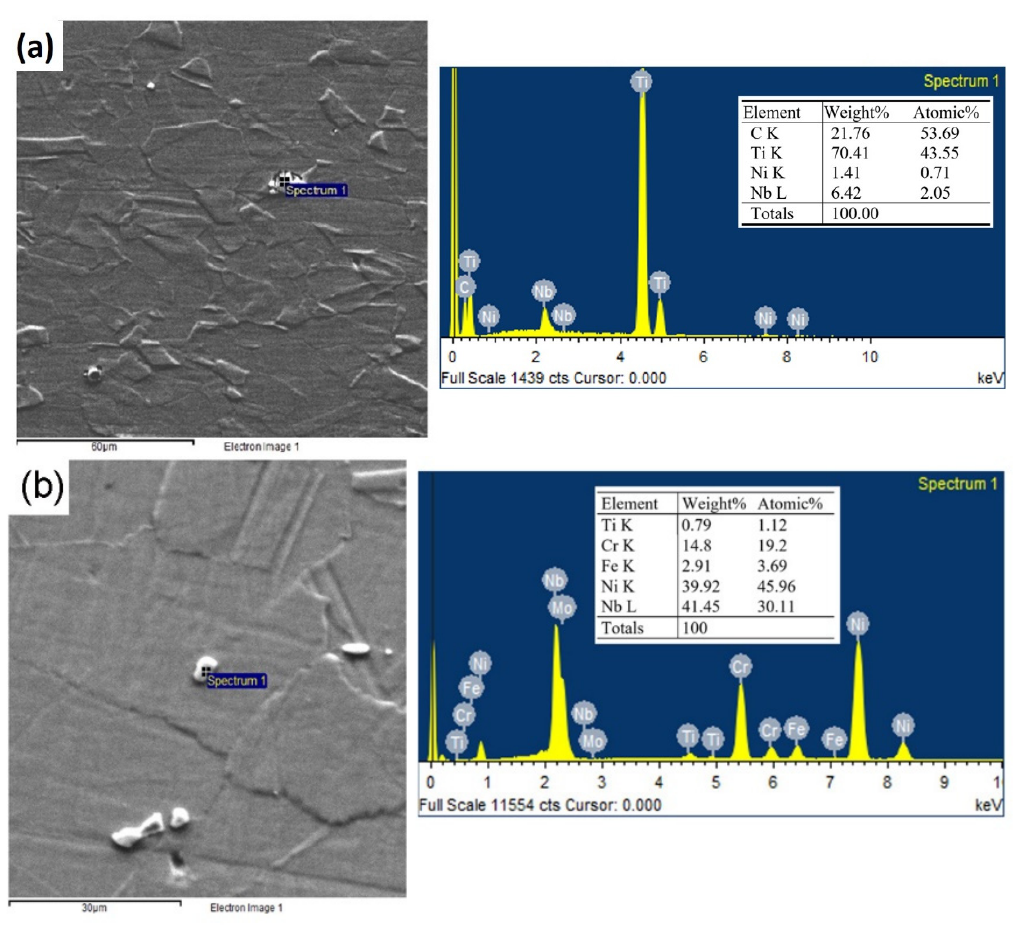
Figure 4. Scanning electron micrograph and EDS analysis of the precipitates present in ( a ) Inconel 718 and ( b ) 625 base metals.